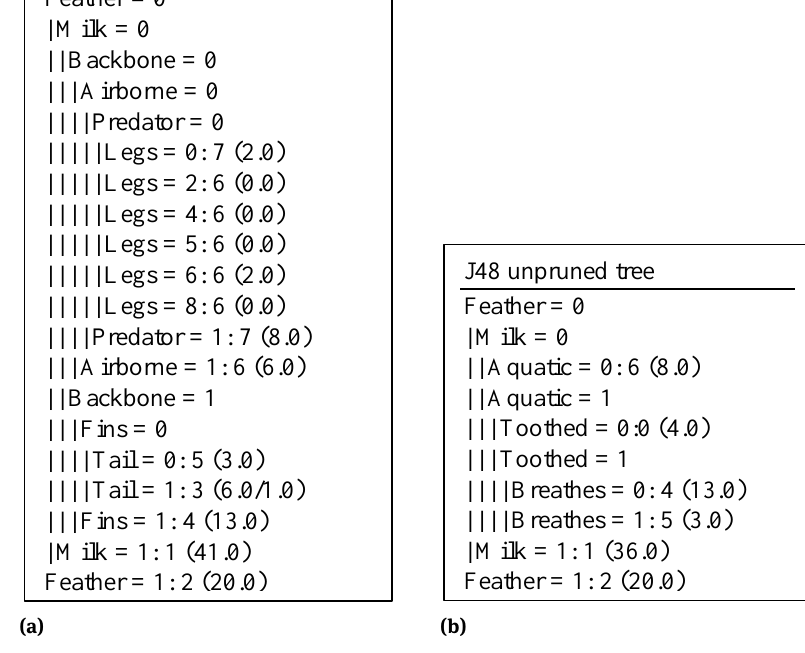
Figure 1: Decision tree for Zoo dataset with 0% noise built using (a) Full dataset, (b) RENN Reduced